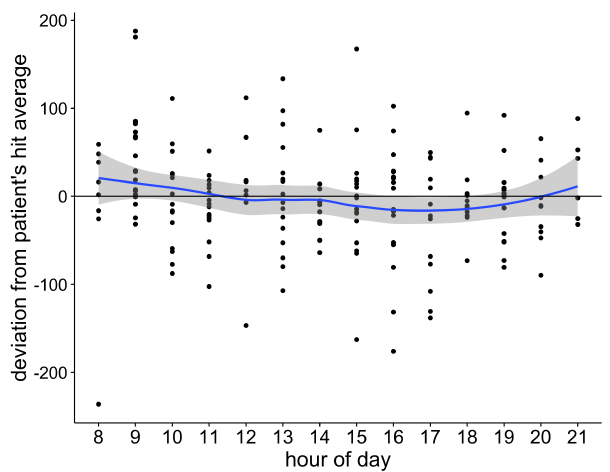
Figure 6. WAM hit performance as deviation from patients’ averages by hour of